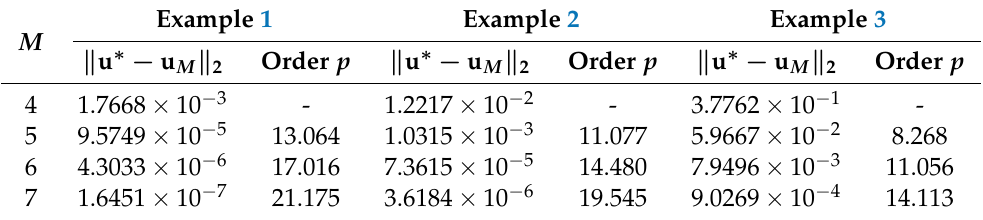
Table 6. Convergence orders of the approximate solutions for Examples